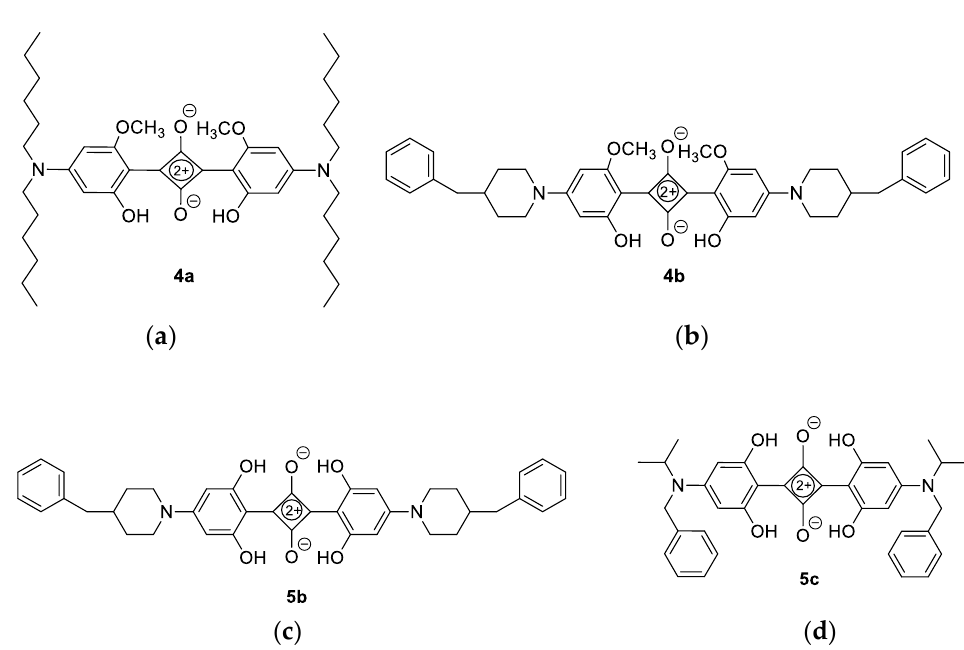
Figure 4. Structures of the derived products: ( a ) 2,4-bis(4-(dihexylamino)-2-hydroxy-6-